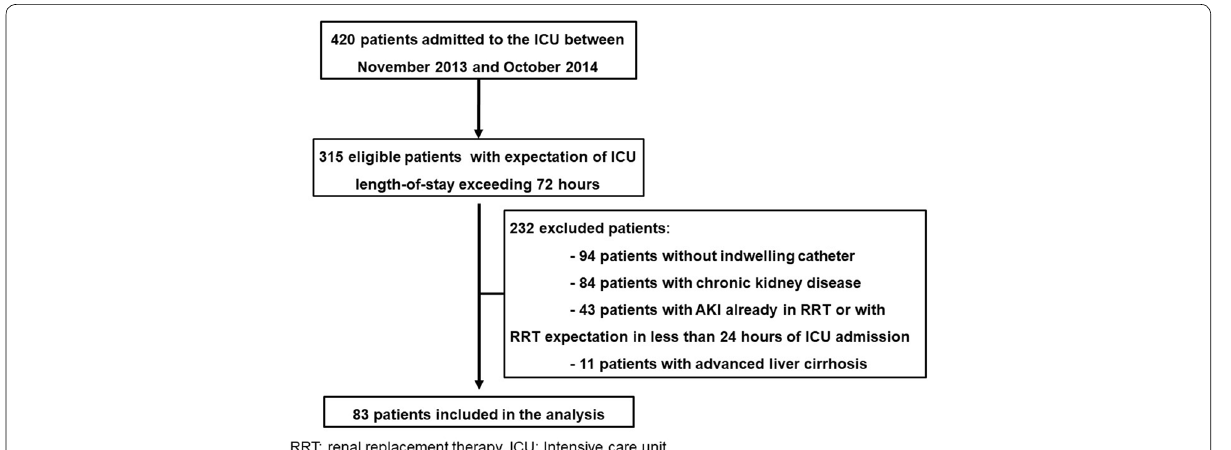
Fig. 1 Flowchart of patients eligible and included in this